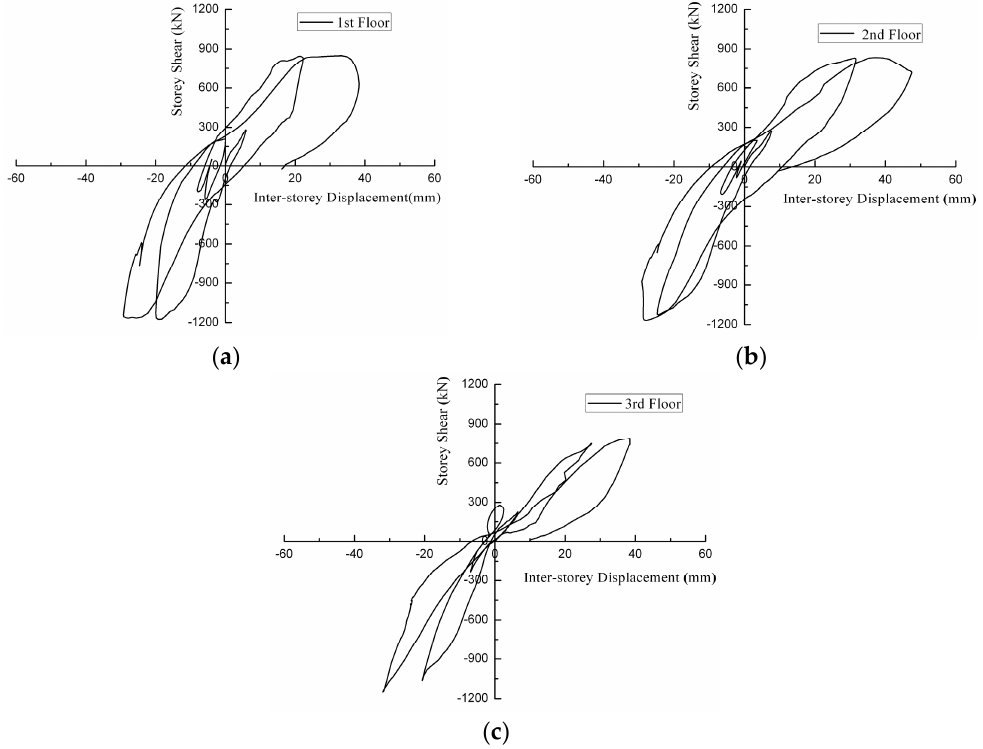
Figure 20. Relationship of the inter-story restoring force and story drift in the physical substructure under the peak ground acceleration of 220 gal for ( a ) 1st floor; ( b ) 2nd floor; ( c ) 3rd floor.